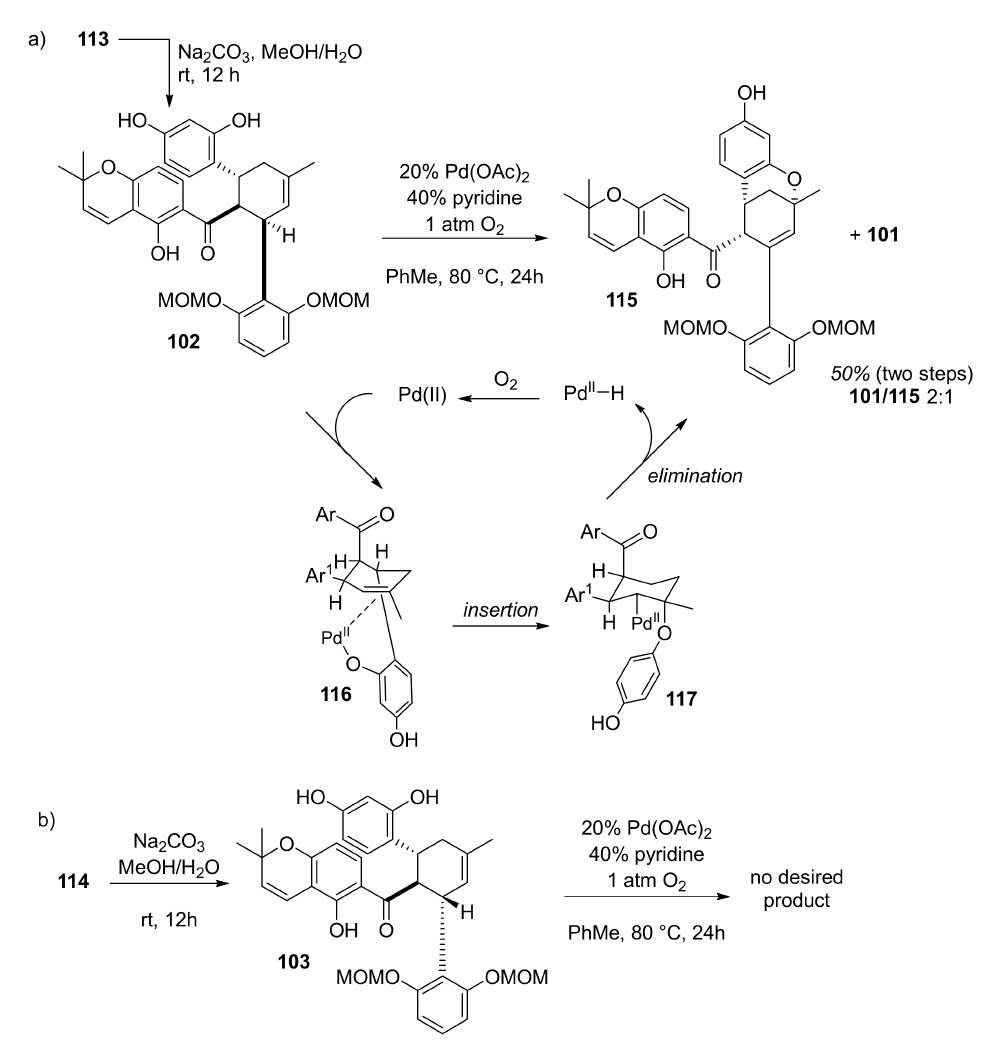
Figure 34. Pd(II)-catalysed oxidative